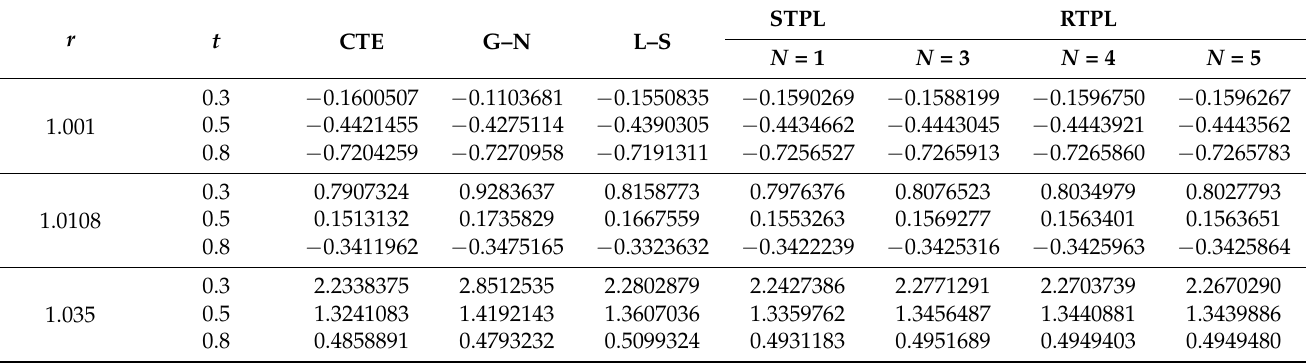
Table 1. Different thermoelasticity theories with a range of r values show the effects of dimensionless time t on volumetric strain e